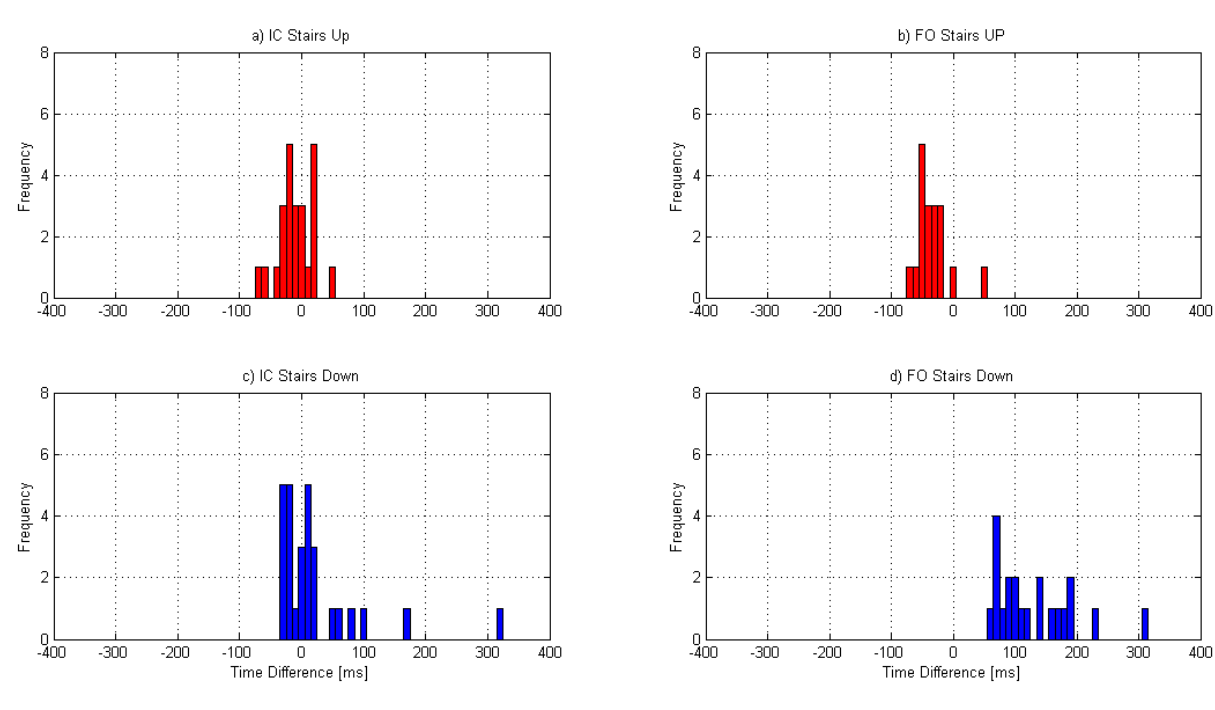
Figure 3. Frequency distribution of the time differences between the gyroscope and the reference method for IC and FO event detection for up the stairs walking ( a ) and ( b ); and down the stairs walking ( c ) and ( d ). The number of events considered was 24 IC and 18 FO for Stairs Up and 28 IC and 21 FO for Stairs Down. Positive differences indicate that the gyroscope method detected the event earlier than the